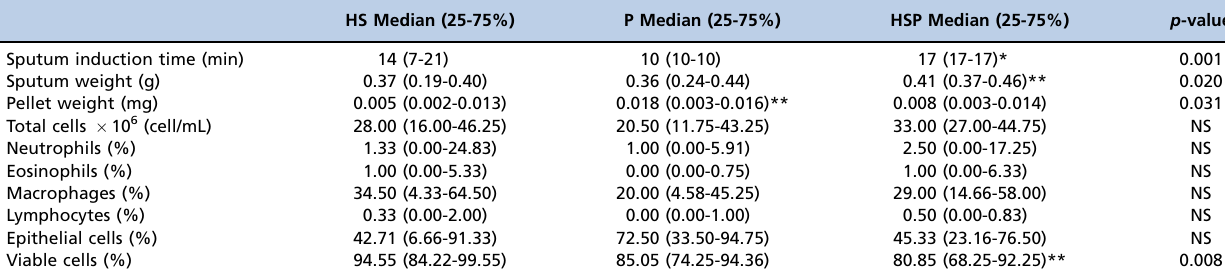
Table 2 - Induced sputum